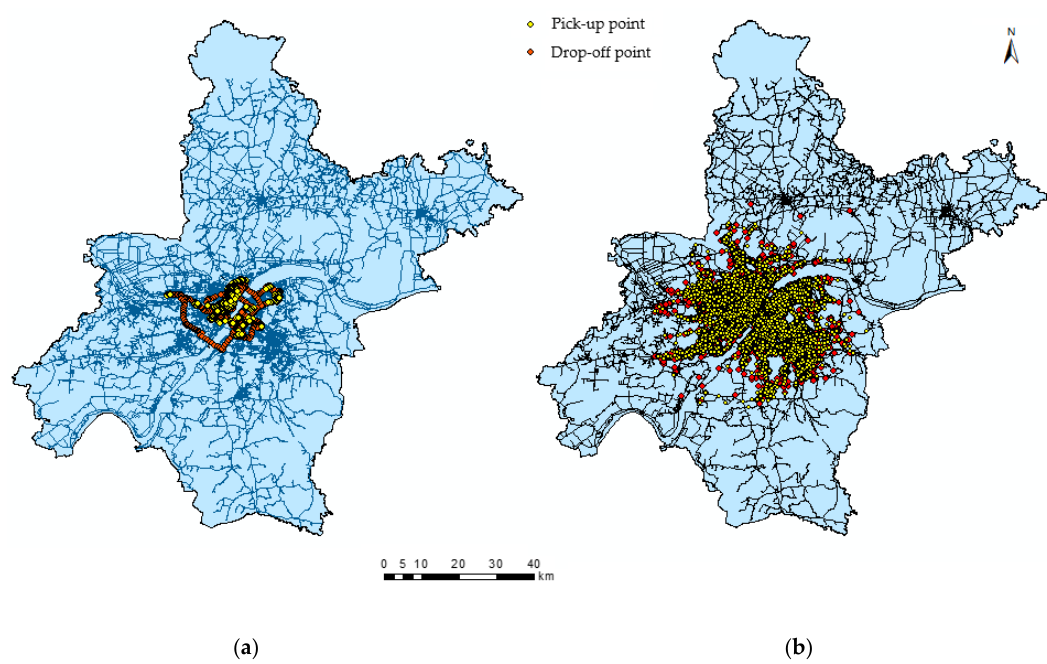
Figure 2. ( a ) Spatial distribution of pickups and drop offs of a taxicab on 2 June 2014; ( b ) spatial distribution of pickups and drop offs of all taxicab on 2 June 2014. Yellow points and red points denote pick-up points and drop-off points, respectively.